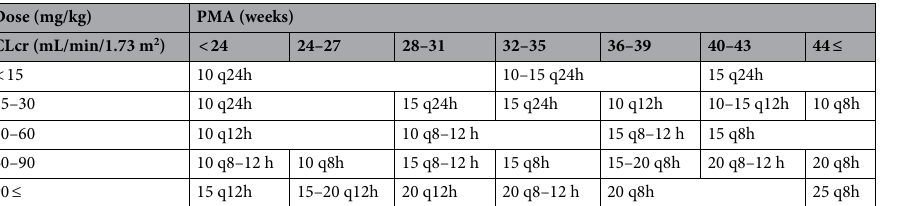
Table 3. Dose recommendations for vancomycin in neonates. CLcr creatinine clearance, PMA postmenstrual age.